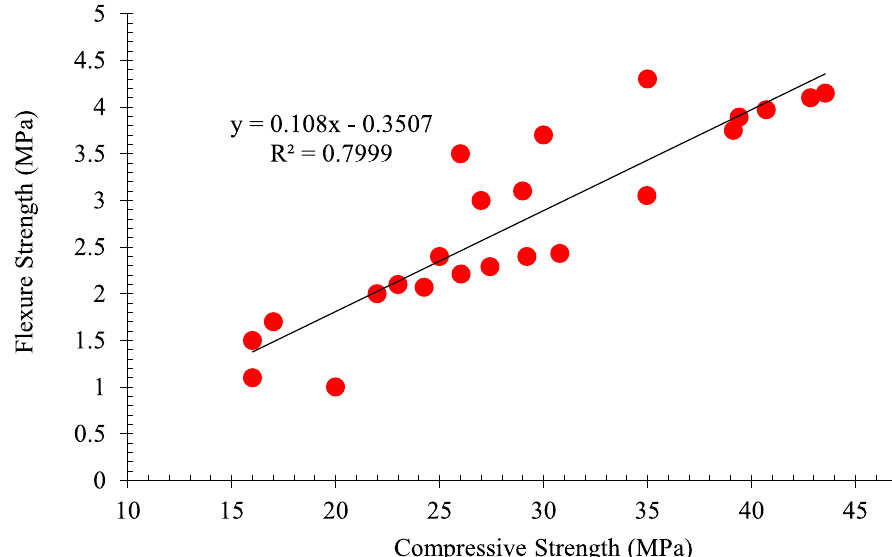
Fig. 11 Correlation between compressive strength and flexural strength (Ofuyatan et al., 2022; Rahman et al.,